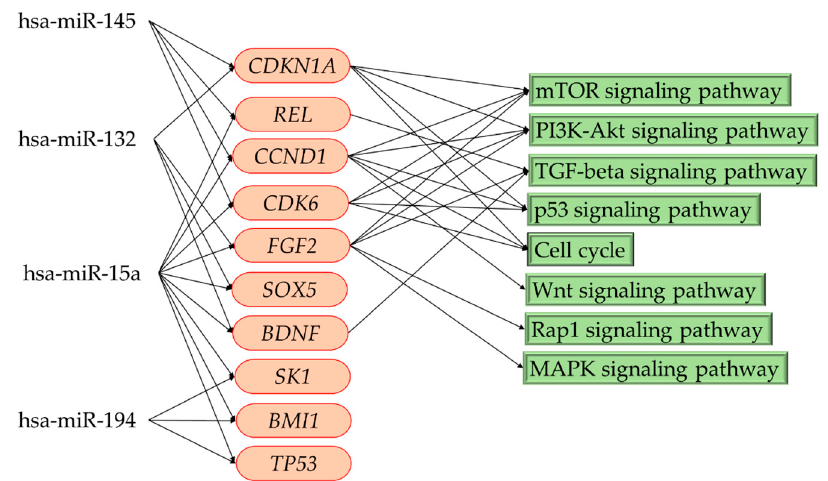
Figure 5. Multiple gene expressions regulated by four target miRNAs; a network model (KEGG) showed the possible pathophysiological pathways related to focal cortical dysplasia. has-miR: Homo sapiens microRNA.